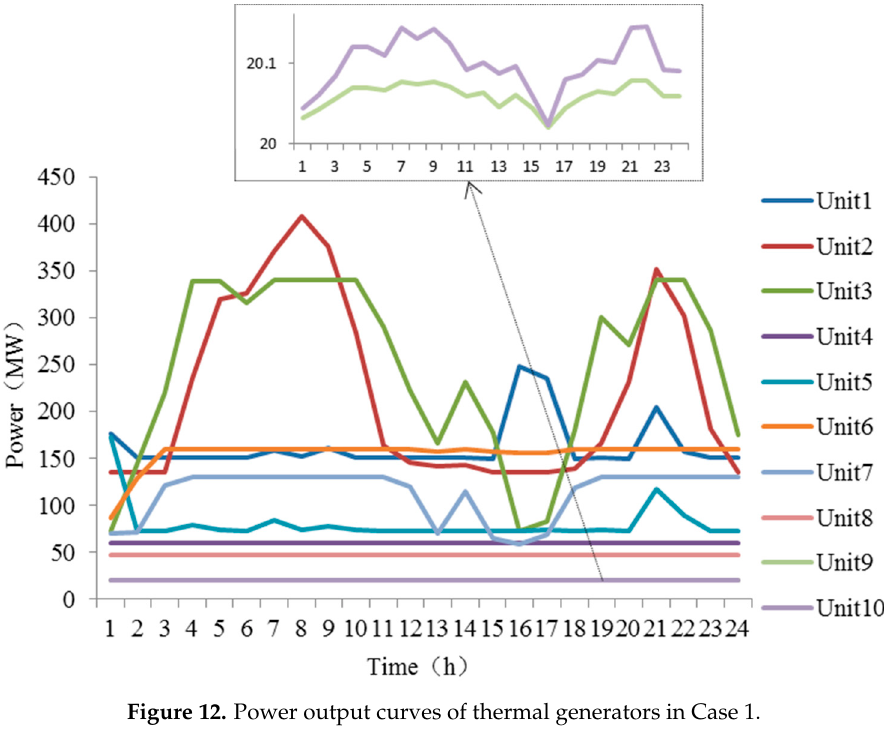
Figure 12. Power output curves of thermal generators in Case 1.